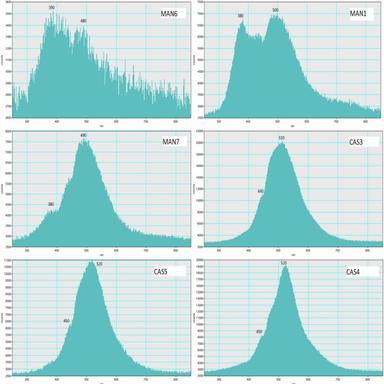
TOP: Representative CL spectra of the glass samples from Manisalis, Thebes (MAN1, MAN6, MAN7) and Cassope, Epirus (CAS3, CAS4, CAS5).